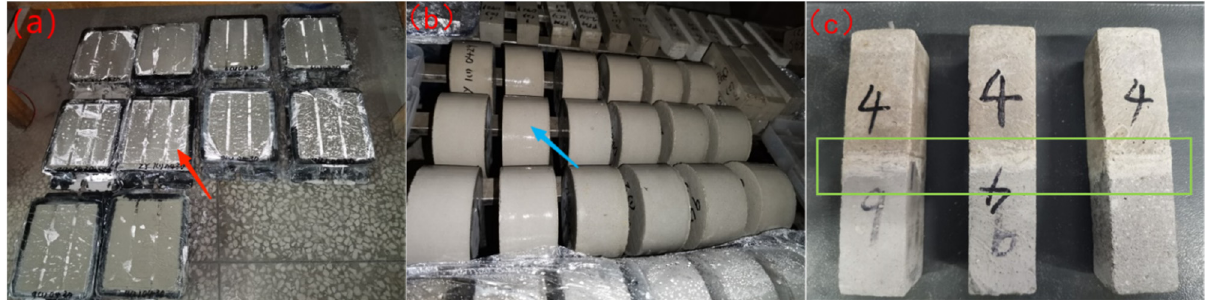
Figure 2: Photos of GOPARMs specimens: ( a ) compressive and fl exural strength test ( red arrow - prism ) ; ( b ) resistance to chloride ion